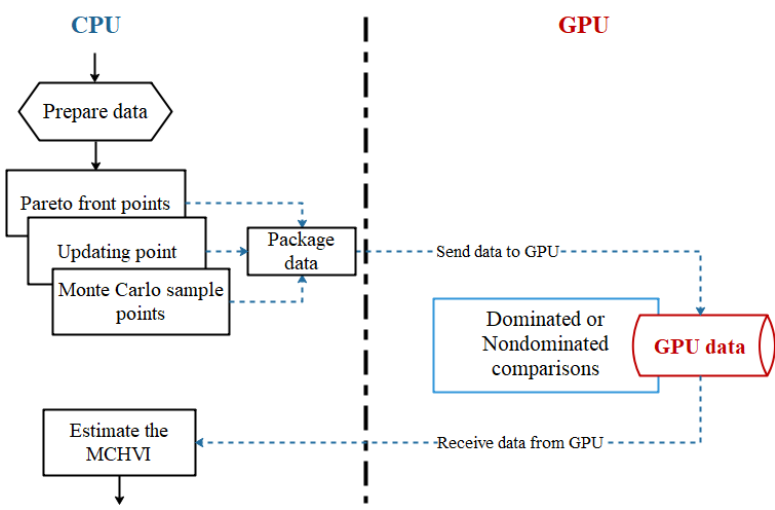
Figure 4. General framework of GPU-based MCHVI indicator value calculations.